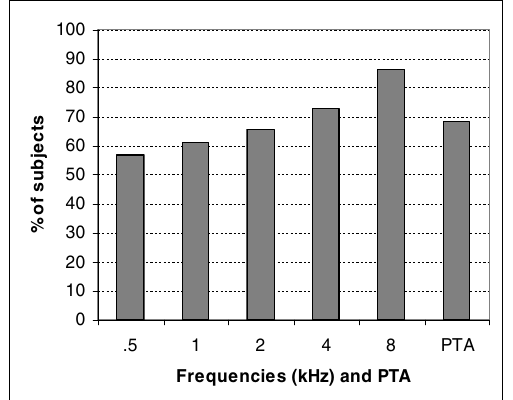
Figure 4 Glomerular filtration rate (GFR) against mean bilateral pure- tone averages (0.5, 1, and 2 kHz) in 22 hemizygotes affected with classic Fabry